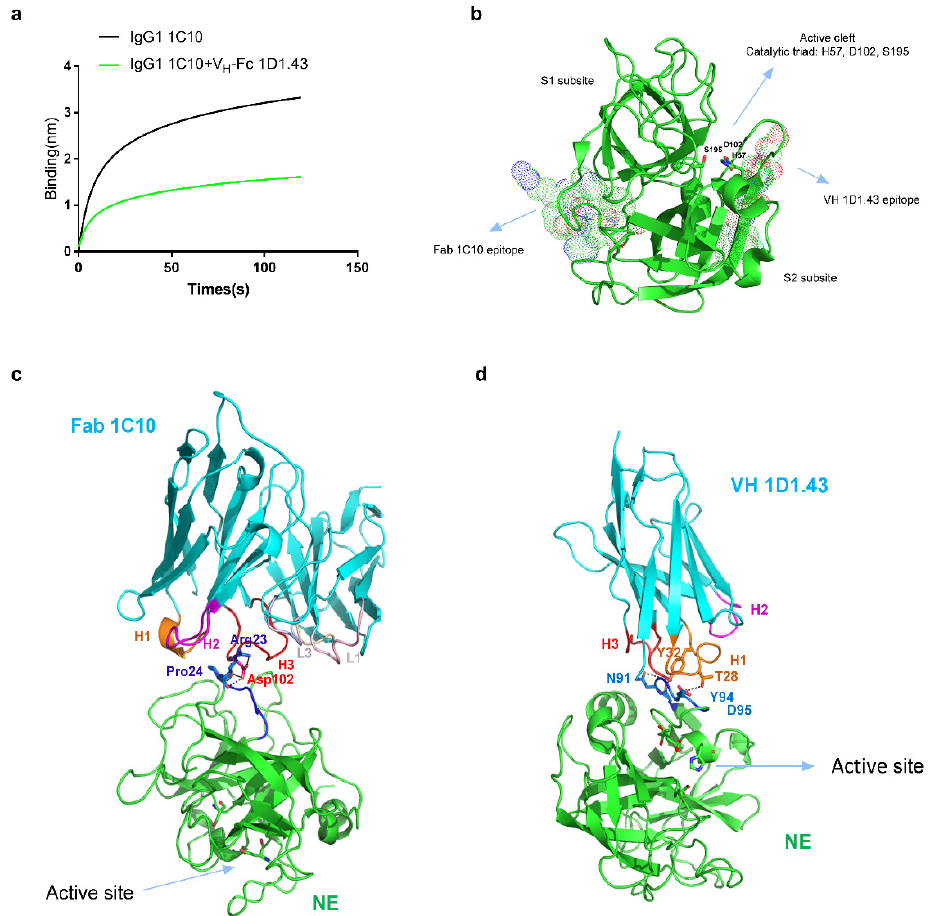
Figure 6. Epitope mapping of V H -Fc 1D1.43 and IgG1 1C10 by using conformational epitope mappings. ( a ) Competition between V H -Fc 1D1.43 and IgG1 1C10 measured by BLItz. ( b ) The binding region of V H 1D1.43 and Fab 1C10 on hNE (PDB: 3Q76) based on the conformational epitope mapping results with the binding motifs highlighted by dot presentations. The enzymatic sites are shown by the stick models. ( c , d ) The detailed binding model of Fab 1C10 and V H 1D1.43 on hNE, as predicted by Z-DOCK programs. Human NE is represented as green cartoons with active site highlighted by sticks and binding epitope highlighted by blue color. Fab 1C10 and V H 1D1.43 are represented as cyan cartoons with highlighted colored CDR loops.